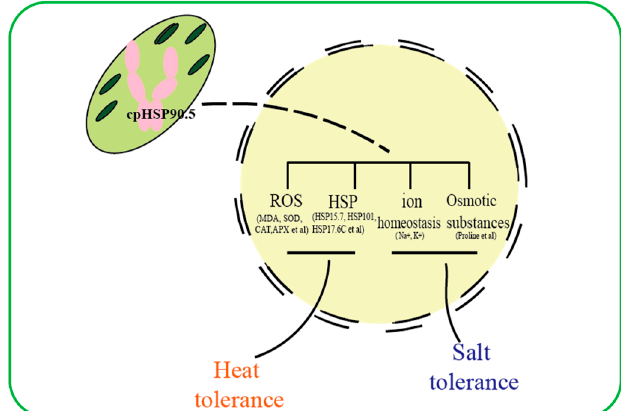
Figure 11. Working model of CmHSP90.5 in response to heat and salt stresses. Light green oval: chloroplast, yellow circle: nucleus, pink oval: chloroplast-located CmHSP90.5.